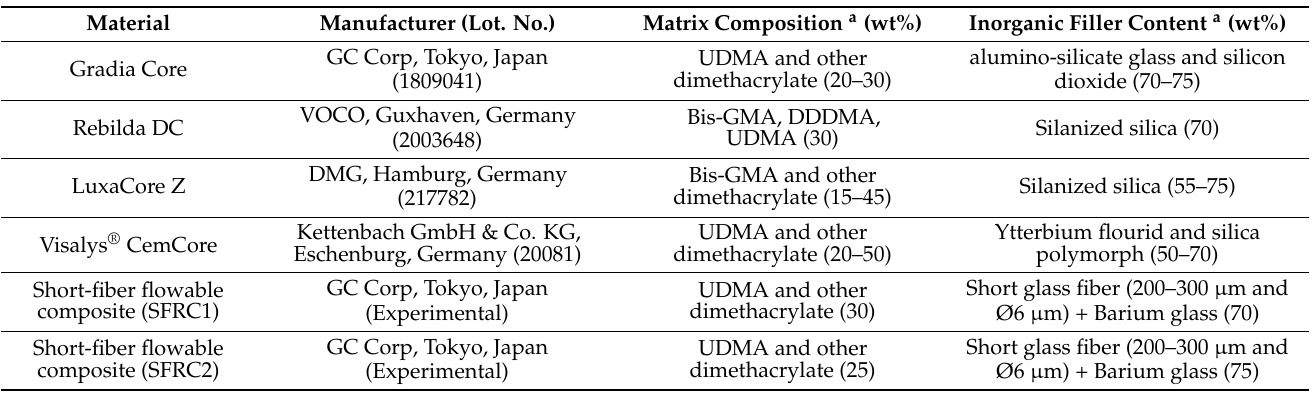
Table 1. Materials